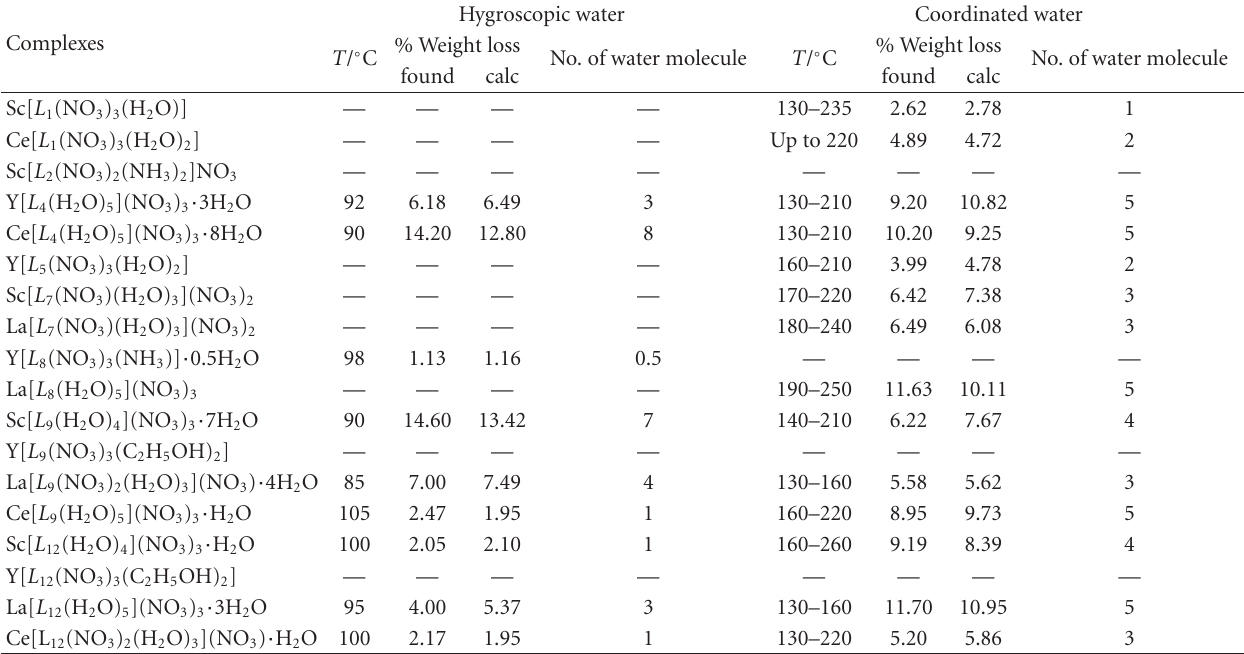
Table 7: Thermogravimetric results of the